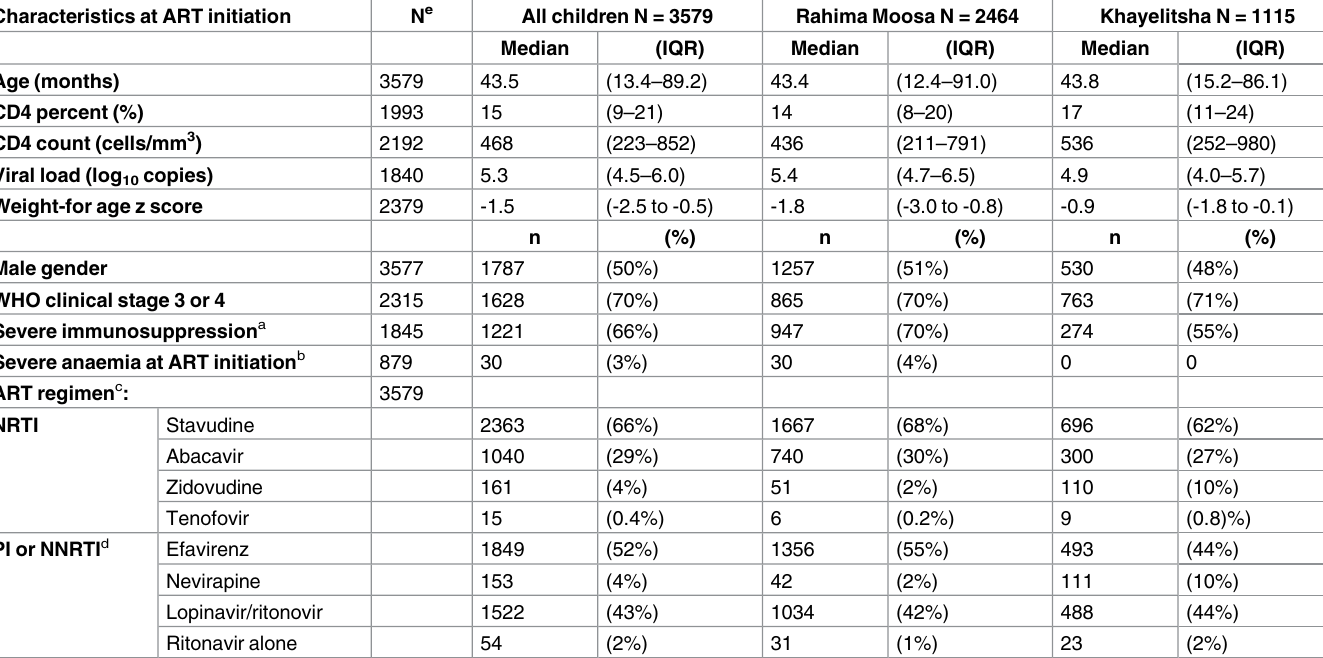
Table 1. Characteristics of children initiated on antiretroviral treatment (N =